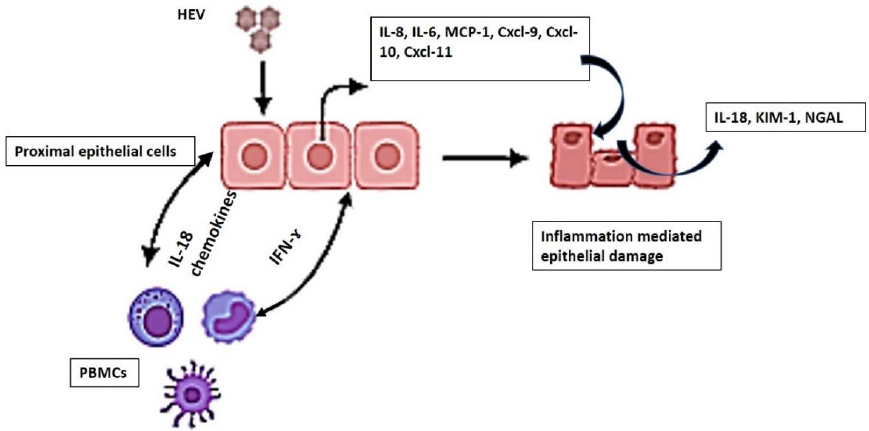
Figure 6. The crosstalk between the renal epithelium and PBMCs following HEV infection. Schematic showing the crosstalk between the epithelium and the immune cells (PBMCs) and the interplay between IFN-γ, chemokines, and IL-18 are the main mediators of HEV-induced renal epithelium damage .